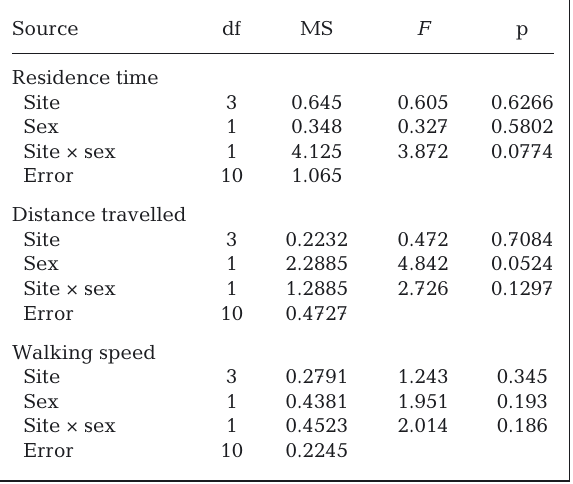
Table 3. Results of 2-way ANOVAs evaluating the effects of ‘site’ (west, east, resident farm, and introduced farm) and ‘sex’ on residence time, total distance travelled, and average walking speed during post-acclimation in 2014